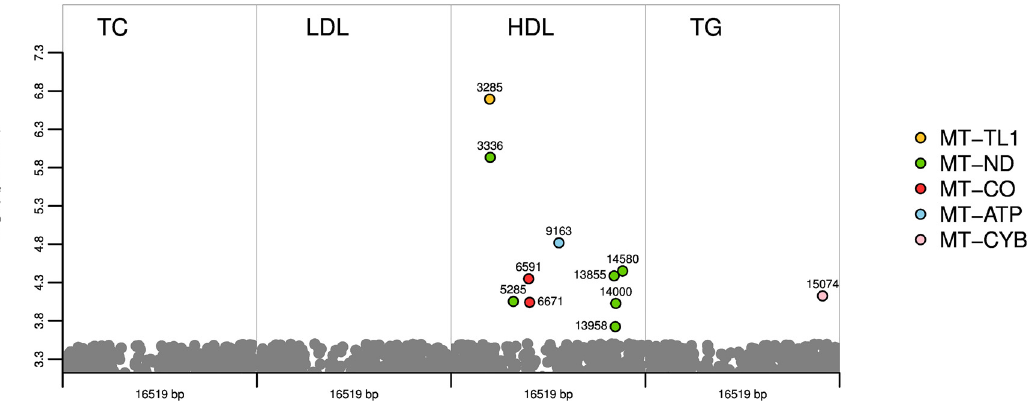
Fig 1. Illustration by phenotype of the 11 significant mtSNPs after correcting for multiple testing. On the y axis, the p-values transformed into the negative of the base 10 logarithm, − log 10 (p-value), are shown. The x-axis represents the mitochondrial genome for each phenotype.